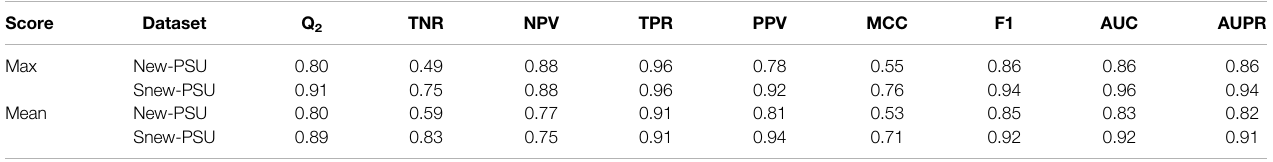
TABLE2| PerformanceofThermoScan ontheNew-PSUandSnew-PSUdatasets.TheThermoScanthresholdsobtainedintheoptimizationstepwithmaximumandmean paragraph/table scoring methods are 3.00 and 1.36 respectively. The performance measures are de fi ned in Supplementary Materials . Score Dataset